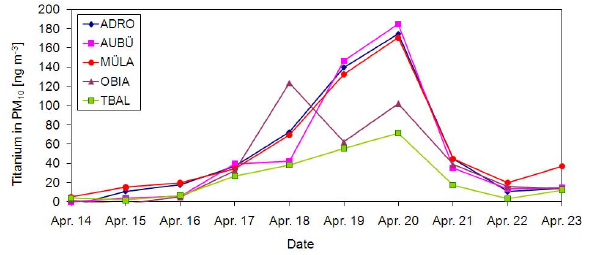
Fig. 9. Surplus in concentration of the elements Ti, Mn, Sr, Y, and Zr in ambient PM 10 on 19 April and 20 April over the average concentration in the reference period (14, 15, 16, 22 and 23 April) at five L ¨UB sites (see Fig. 1 also: Andechs/Rothenfeld (ADRO), Augsburg (B¨urgermeister-Ulrich- Strasse) (AUB ¨U), M¨unchen (Landshuter Allee) (M ¨ULA), Oberau- dorf (Inn valley motorway) (OBIA), Tiefenbach/Altenschneeberg